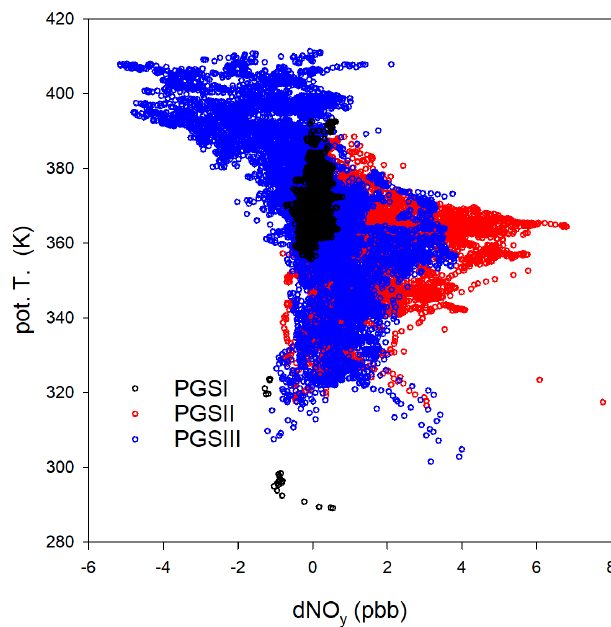
Figure 8. dNO y colour-coded for the three POLSTRACC phases (early, mid, and late winter) versus potential